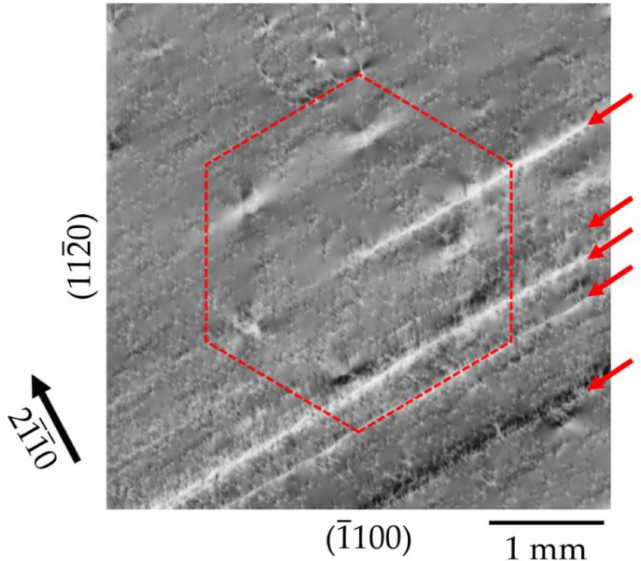
Figure 16. HCD (marked with a hexagon) formed on chains of threading dislocation bundles (red arrows) of a tiling seam. This allows a chronological assignment of the development of this defect cluster in the stages of seed